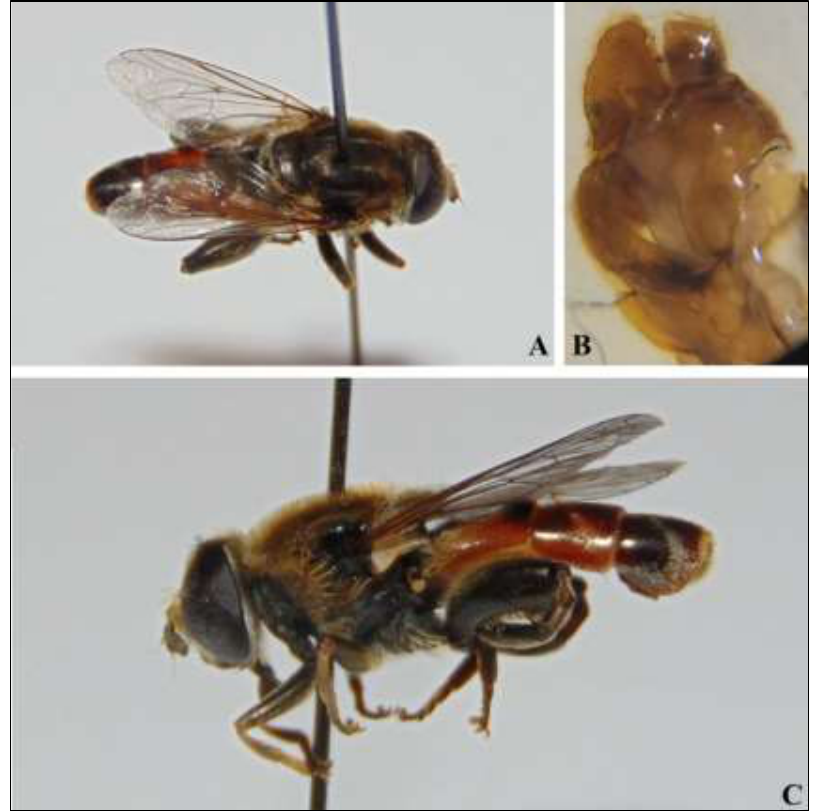
Figure 4. Merodon testaceus Sack, 1913; A, C – habitus of male (A – dorsal view; C – lateral view); B – terminalia of male. (Photo: M. Vujić,